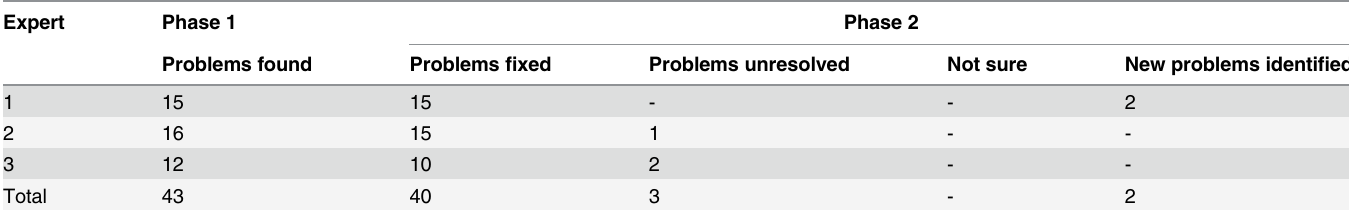
Table 11. Results of both phases of